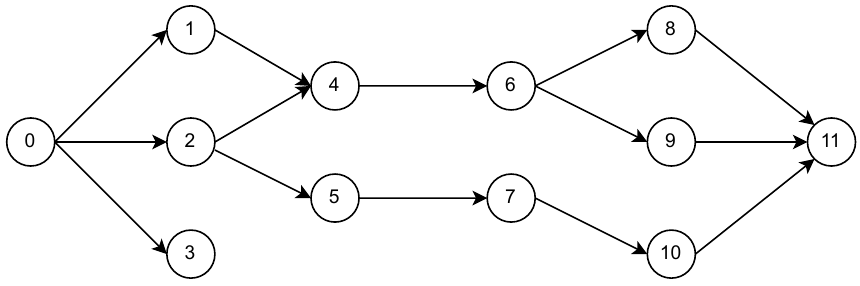
Figure 1. The precedence graph of an instance of the RCJS